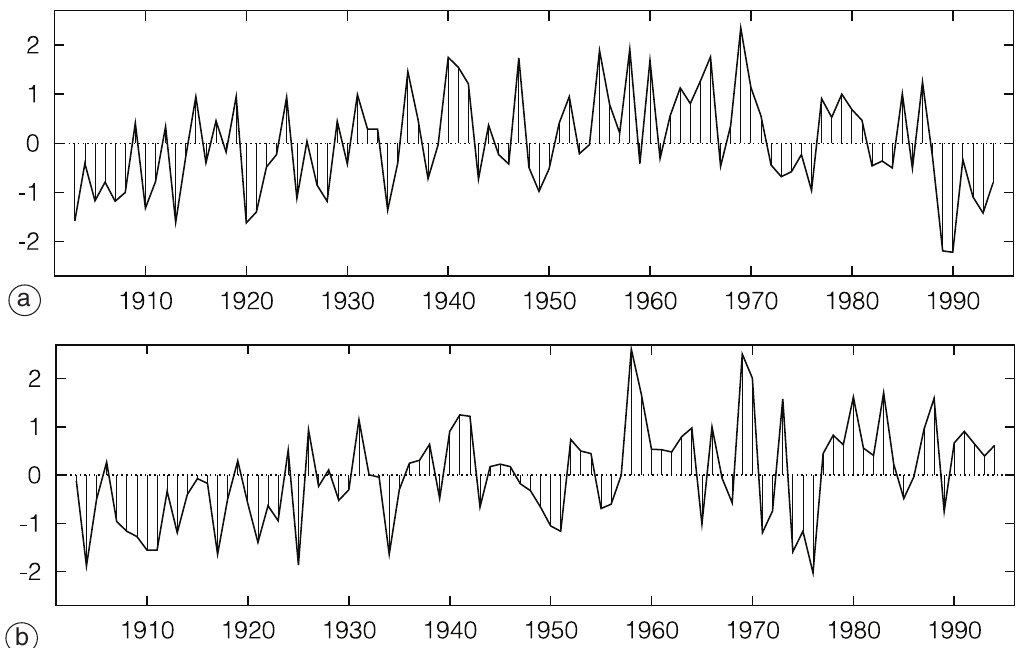
Fig. 2a,b. Standardised time series for the patterns in fig. 1a,b. a) For Atlantic/European MSLP; b) for tropical SST. Correlation coefficient between time series is